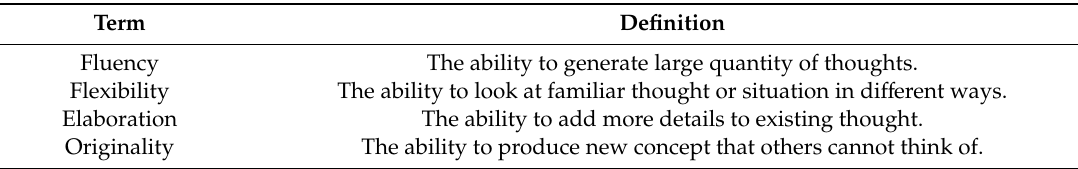
Table 2. Definitions of key terms related to